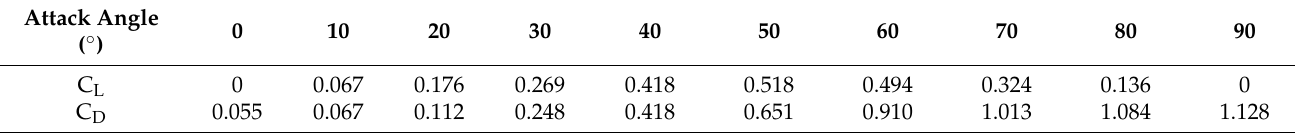
Table 1. Effect of attack angle on the lift and drag coefficients of rope